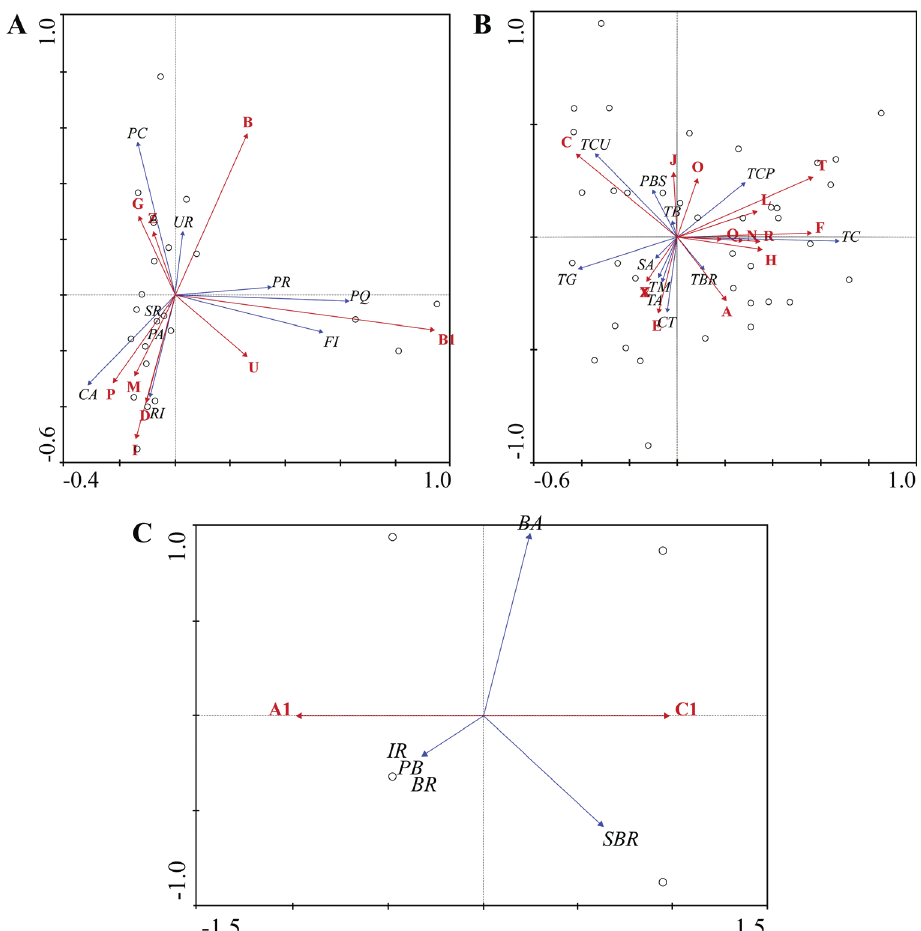
FIGURE 4 | Results of the Redundancy Analysis (RDA) of the definition of the ethnospecies by the artisanal fishers from the Caeté-Taperaçu Marine Extractive Reserve in Bragança, northern Brazil, with the characteristics that best identify each taxon. A. CA : ‘caica’, PA : ‘pratiqueira’, PR : ‘pratiqueira/ ribação’, SR : ‘sajuba/ribação’, RI : ‘ribação’, UR : ‘urubarana’, PQ : ‘pratiqueirão’, FI : ‘filhotes’; B: narrow body, B1: juvenile of large mullet, D: does not grow a lot, G: narrow headed, I: small headed, M: small eyed, P: small scales, U: does not jump, Z: smells. B. TA : ‘tainha’, TM : ‘tainha macho’, TBR : ‘tainha branca’, TB : ‘tainha boi’, TC : ‘tainha chata’, TGP : ‘tainha grande/puá’, TG : ‘tainha grande’, TCU : ‘tainha curimã’, CT : ‘caica tamatarana’, SA : ‘sajuba’, A: rounded body, C: grows a lot, E: back dark/bluish, F: flattened head, H: rounded head, J: large headed, L: large eyed, N: red eyed, O: large scales, Q: rounded scales, R: shiny scales, S: scales close together, V: smart, X: stupid. C. PB : ‘pratiqueira/barrasco’, BA : ‘barrasco’, BR : ‘barrasco/ribação’, SBR : ‘sajuba/barrasco/ribação’, IR : ‘irichona’, A1: sexual dimorphism, C1: ‘baby